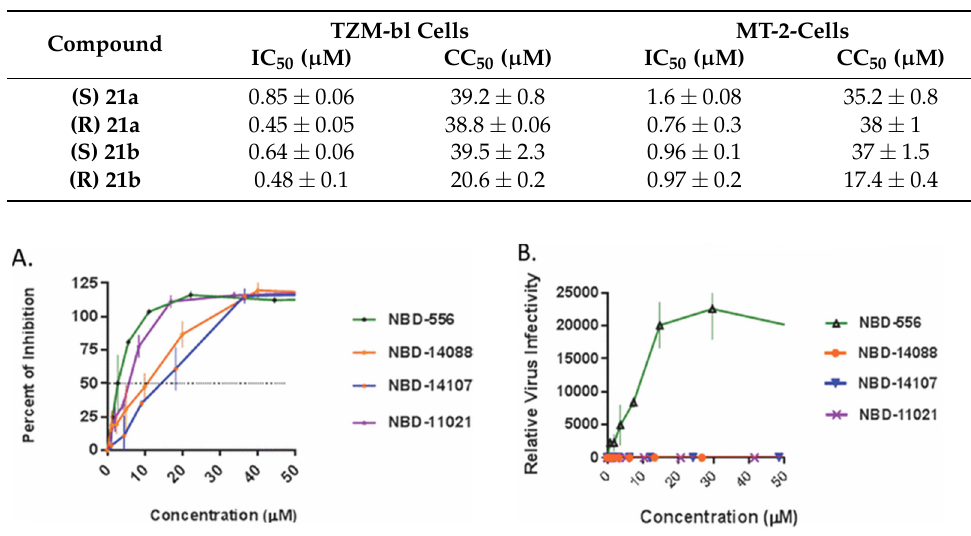
Table 3. The SAR study of the compounds against HIV-1 in TZM-bl and MT-2 cells [29].